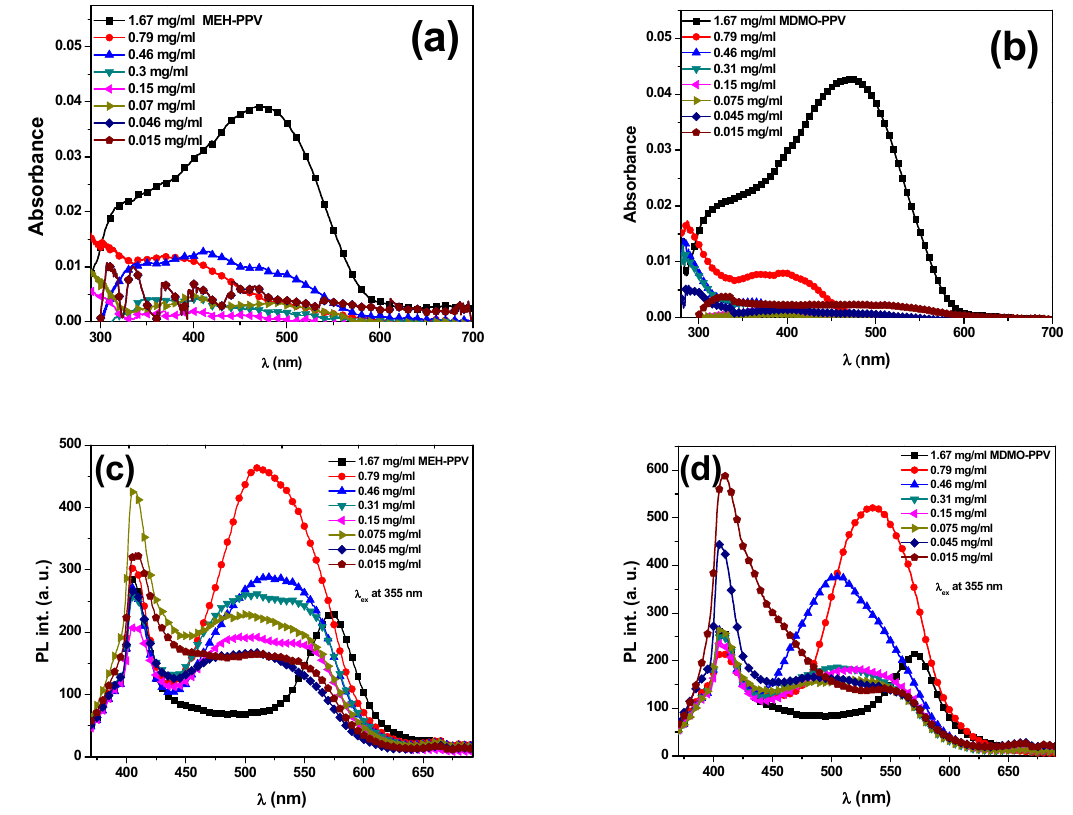
Figure 5. Absorption spectra at various concentrations of ( a ) pristine MEH-PPV and ( b ) pristine MDMO-PPV–DMP, and ( c , d ) their fluorescence spectra, respectively, with excitation wavelength of 355 nm.